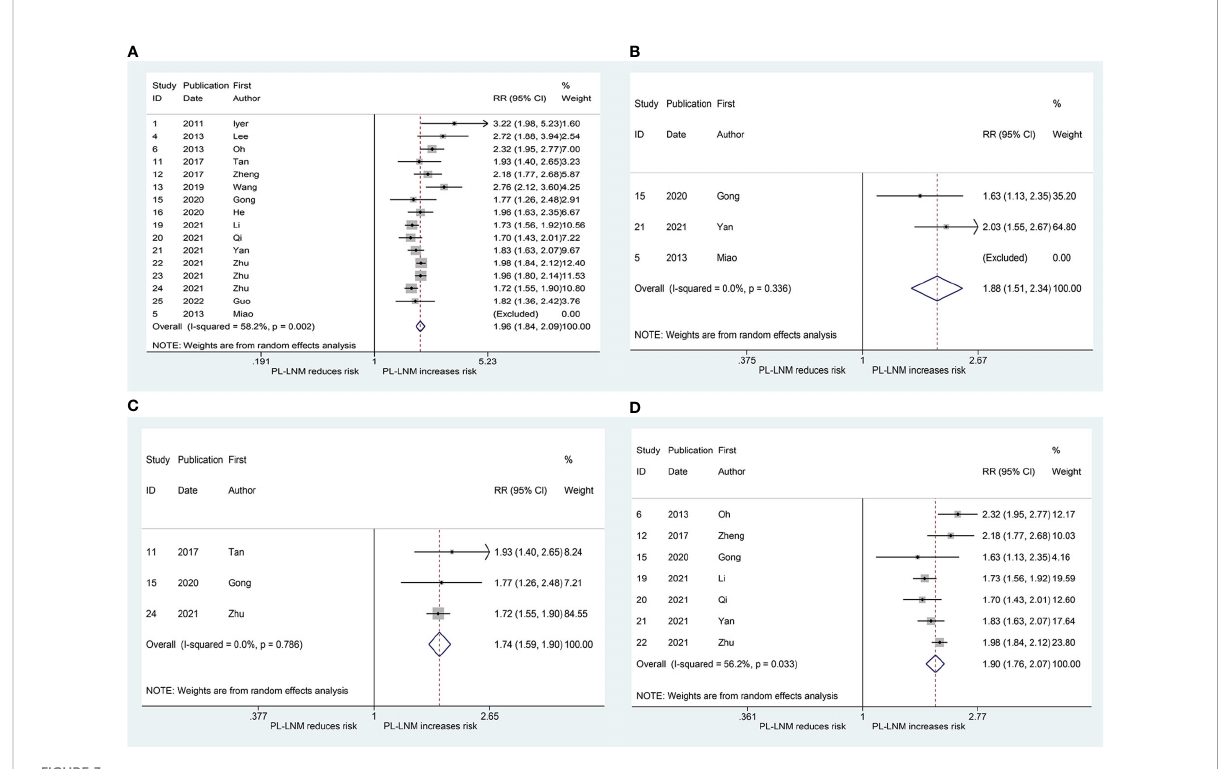
FIGURE 3 The relative risk for central (without prelaryngeal) lymph node metastasis in patients with prelaryngeal lymph node metastasis (PL-LNM). (A) The overall. (B) Subgroup of non-bilateral papillary thyroid carcinoma. (C) Subgroup of inclusion of cases without prelaryngeal lymph node. (D) Subgroup of exclusion of cases without prelaryngeal lymph